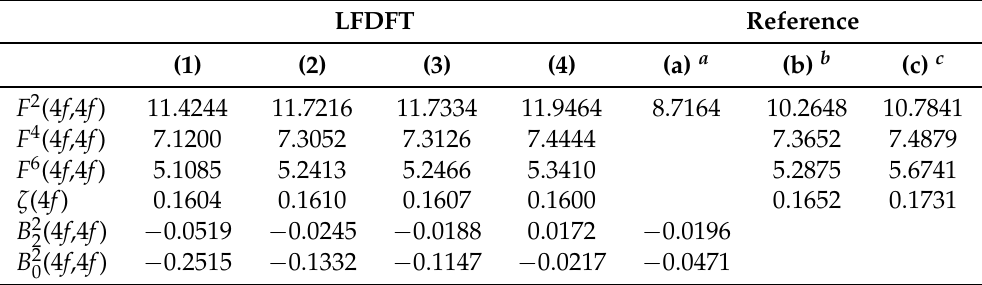
Table 2. Calculated parameters of the ligand-field Hamiltonian: Slater–Condon integrals, spin-orbit coupling constant and the ligand-field potential in terms of the Wybourne-normalized crystal-field parameters (in eV) obtained from LFDFT using the PBE (1) [37], B3LYP (2) [38], PBE0 (3) [39,40] and KMLYP (4) [41] functional, compared with reference data taken from the literature: experimental parameters (a), average free-ion parameter (a) and other theoretical model